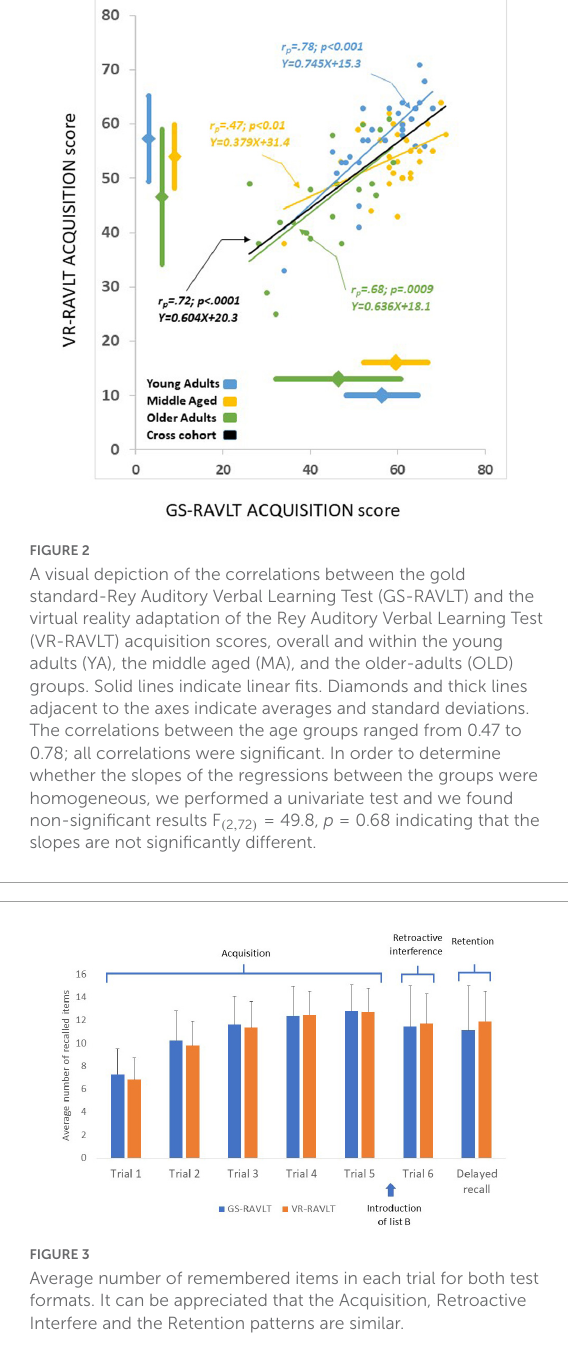
RETENTION, r = 0.31, p = 0.005; RI, r = 0.18, p = 0.10; all 78 participants were included in this analysis, Post hoc power calculations are provided in section 2 of the Supplementary material , suggesting construct validity of the VR-RAVLT (see, e.g., Figure 2 ). To demonstrate these correlations, Figure 3 depicts the average number of remembered items on each trial for both test